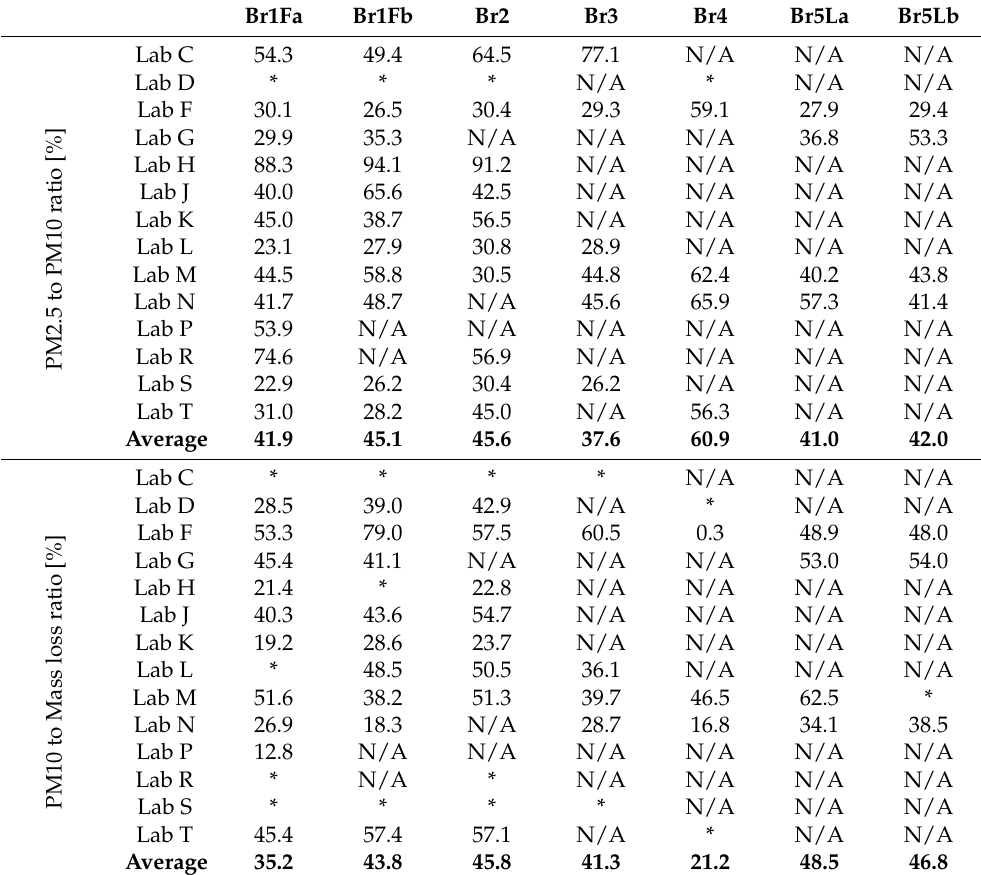
Table 7. Average PM2.5 to PM10, and PM10 to mass loss ratios. Asterisks denote testing facilities that did not measure PM2.5 or mass loss; therefore, the ratio is not available.